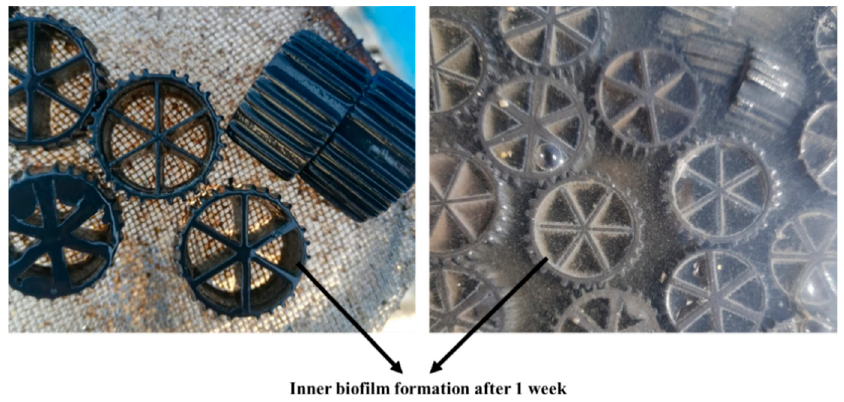
Figure 6. Biofilm formation on the inner carriers surface after 1 week of the start-up.